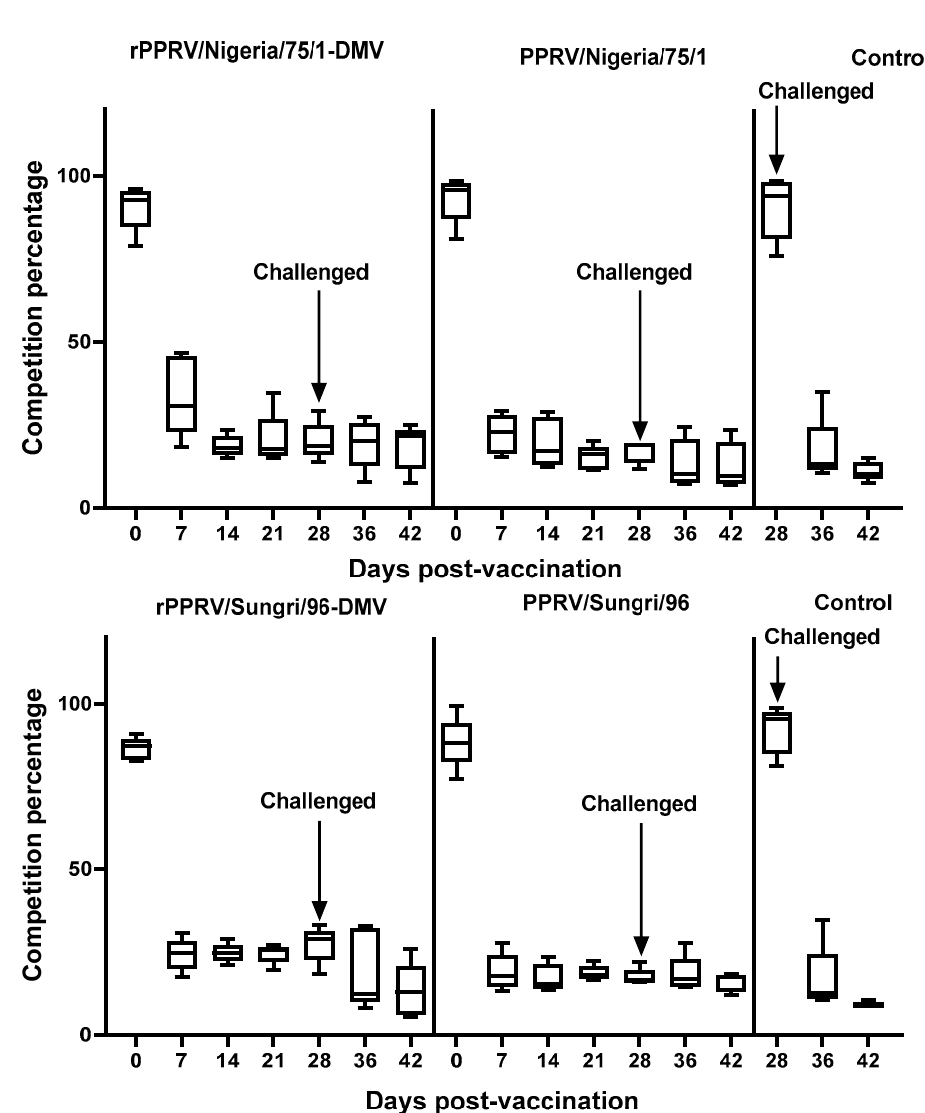
Figure 7. Antibody response in goats to PPRV vaccines. Goats were vaccinated with the recombinant and parental vaccine strains and samples were taken at 0, 7, 14, 21, 28, 36 and 42 days post-vaccination (dpv). Sera taken at all the time points were assayed for antibodies to the PPRV N-protein using the commercially available cELISA kits. Note that the manufacturer’s recommended calculation for the N-protein cELISA kit gives values that decrease as the amount of competing antibodies increases (percent inhibition of binding of mAb). The data are presented as box-and-whisker plots, in which the bars span the minimum and maximum values, and the box shows the range from the first to the third quartile. The central horizontal line in each box shows the median value. The 42 dpv control group data are from two and four animals in Sungri/96 and Nigeria/75/1 experimental groups, respectively.